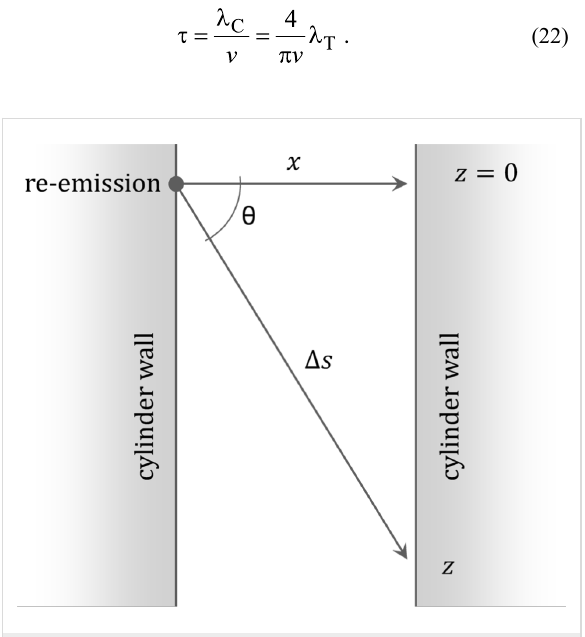
Figure 6: Schematic illustration of the flight geometry between two subsequent collisions of the molecule with a nanocylinder wall. The quantities in the figure are explained in the main